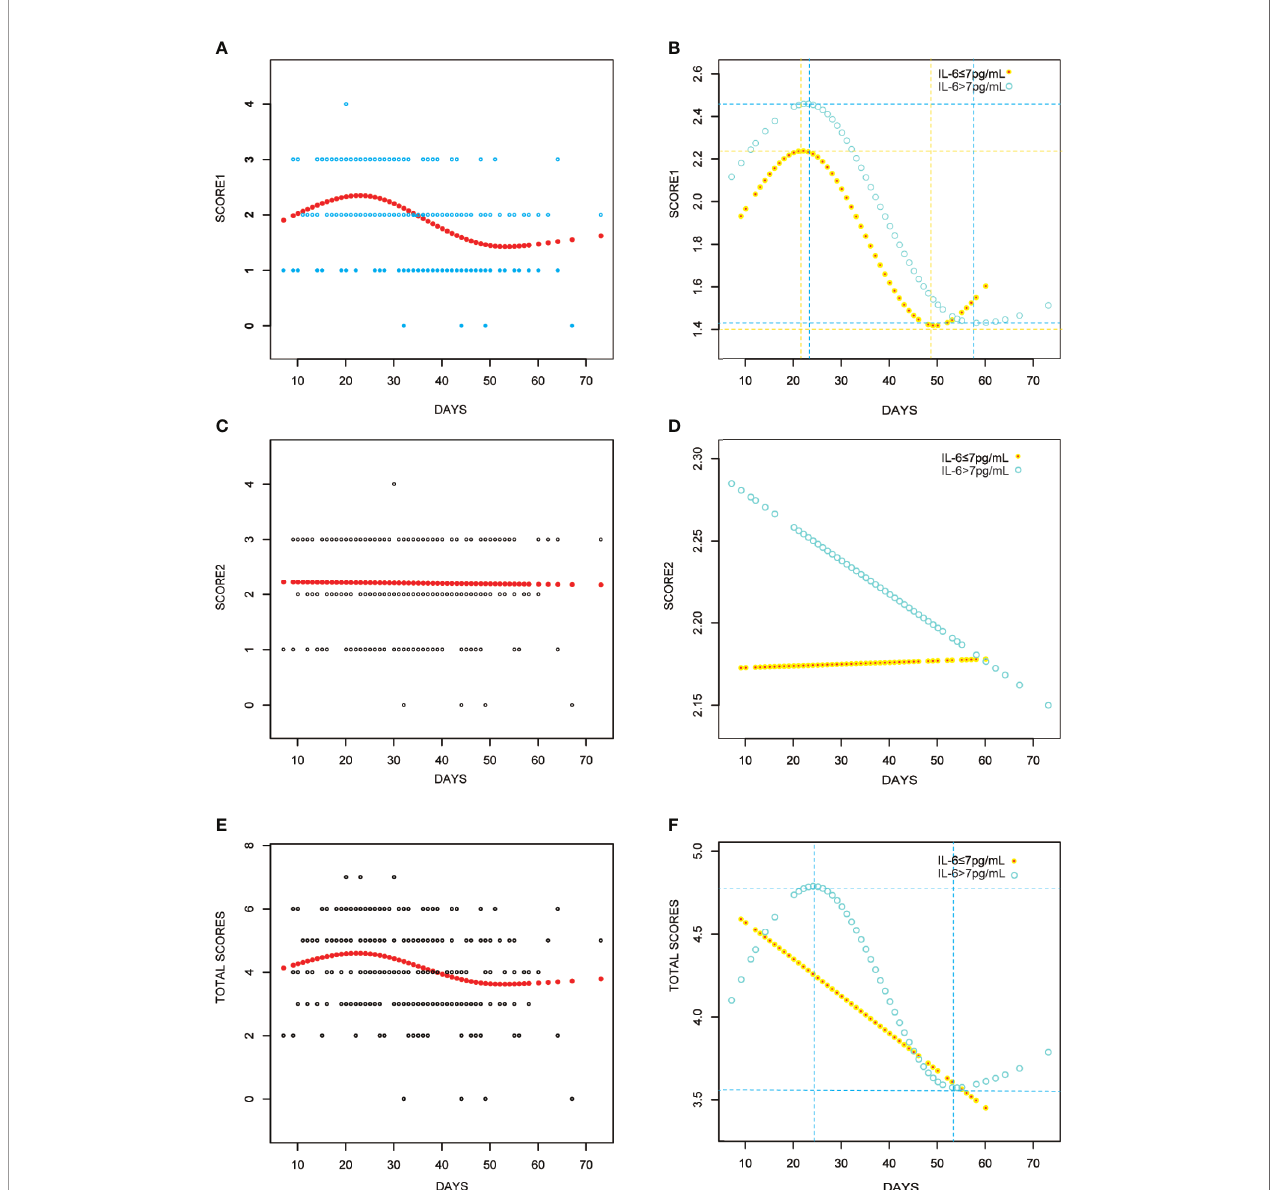
FIGURE 4 | Curve fi tting analyses with CT scores for all COVID-19 patients (A, C, E) ; IL-6 elevated group (IL>7 pg/ml) versus IL-6 elevated group (IL ≤ 7 pg/ml) (B, D, F)